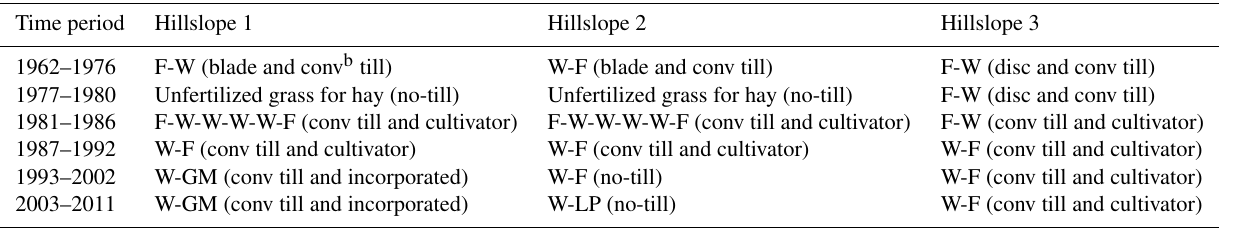
Table 1. Crop rotation a (and tillage) history of the three hillslopes. Time period